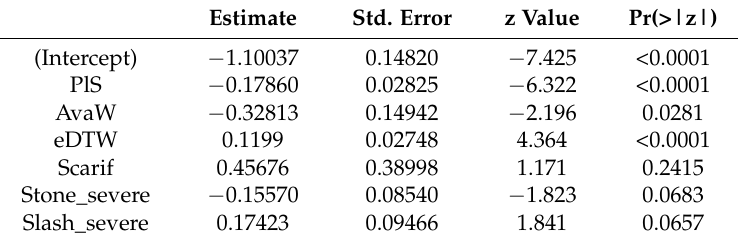
Table 1. Fixed effects full model (Equation (2)), with mortality in sample plots nested within clearcuts. PlS, the number of suitable planting spots; AvaW, Available Water at planting year; eDTW, the transformed DTW value of soil moisture content from raster data; Scarif, scarified sample plot yes or no; Stone and Slash, the classified variables of severity in planting due to stone and slash respectively.